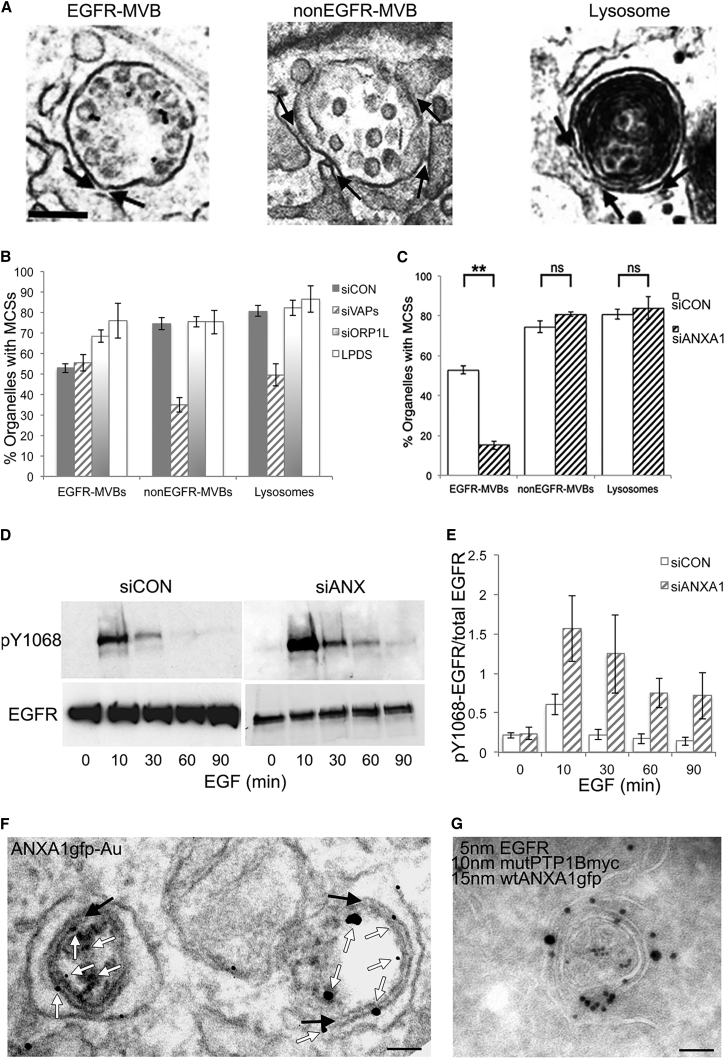
Role of VAPs, ORP1L, and Annexin A1 in MCSs between the ER and Different Endocytic Organelles(A and B) HeLa cells transfected with non-targeting siRNA (siCON) or siRNA targeting VAPA and VAPB (siVAPs) or ORP1L (siORP1L) or cultured overnight in LPDS were stimulated with EGF and anti-EGFR gold (30 min). ER MCSs (arrows) with endocytic organelles (examples in A) were quantified (B). Data are mean ± SD of three experiments. Scale bar, 200 nm.(C) As (B), with siRNA targeting annexin A1 (siANXA1). ns, not significant p > 0.05; ∗∗p < 0.01.(D and E) HeLa cells transfected with non-targeting siRNA (siCON) or siRNA targeting annexin A1 (siANXA1) were stimulated with EGF as indicated, cell lysates blotted with antibodies to phosphotyrosine(pY)1068 or total EGFR (D), and quantified (E). Data are mean ± SD of three experiments.(F) HeLa cells transfected with WT annexin A1-gfp and mutant (D181A) PTP1B-myc were stimulated with EGF-HRP (60 min) and stained for GFP using pre-embedding labeling. GFP (white arrows) is visible at MCSs (black arrows) between the ER and EGFR-MVBs containing electron-dense EGF-HRP DAB reaction product. Scale bar, 200 nm.(G) HeLa cells transfected with annexin A1-gfp and D181APTP1B-myc were stimulated with EGF and anti-EGFR-5 nm gold (30 min). Cryosections were labeled with anti-myc (10 nm gold) and anti-gfp (15 nm gold). Scale bar, 200 nm.See also Figure S1.